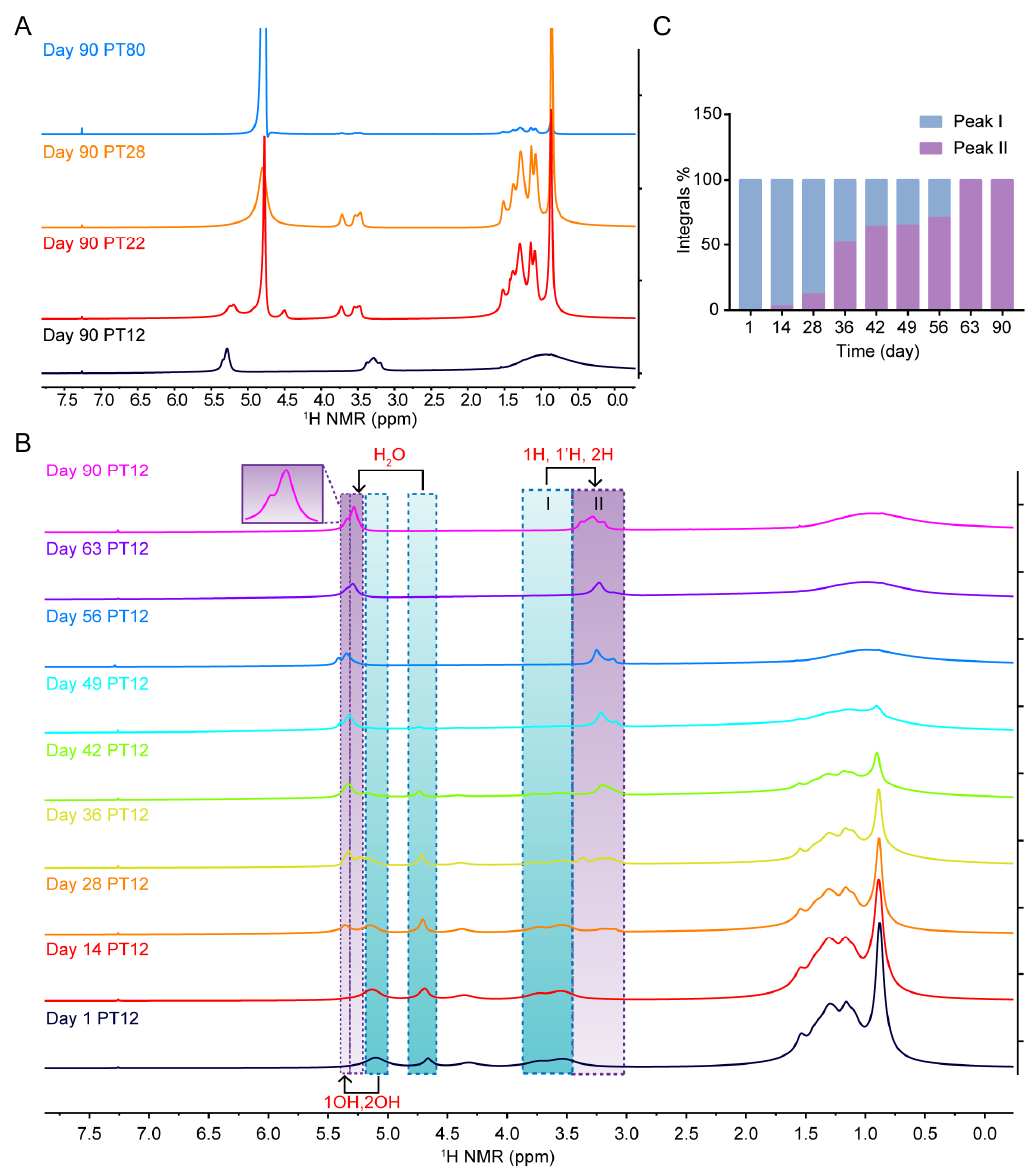
Figure 4. Isotropy and anisotropy of LCP. ( A ) 1 H spectra of LCP and solution with different hydration degree (12 wt %, 22 wt %, 28 wt %, 80 wt %). ( B ) 1 H NMR spectra of PT12 changed with time. ( C ) The integral proportions (%) between peak I and peak II.